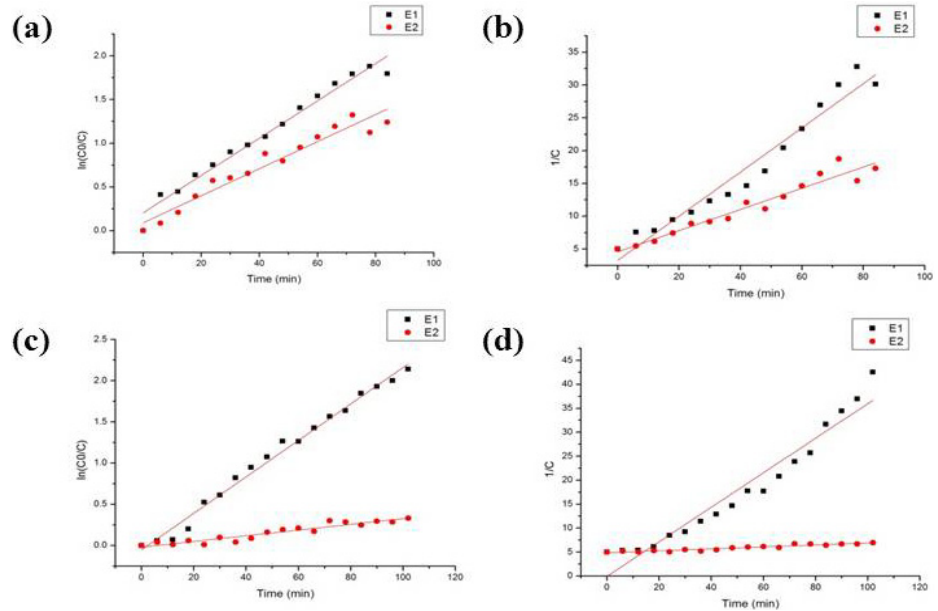
Figure 8. First-order kinetics ( a ) and second-order kinetics ( b ) fit of E1 and E2 removal on PVDF-PVP-TiO 2 membrane under UV photocatalysis; first-order kinetics ( c ) and second-order kinetics ( d ) fit of UV photolysis. Table 1. Constants and correlation coefficients for the kinetic models.